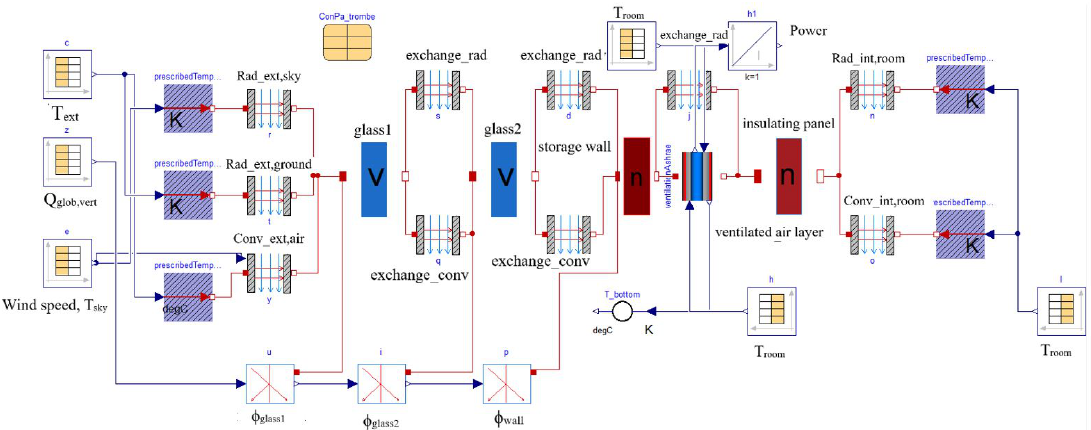
Figure 7. Diagram of a composite Trombe wall model using the Dymola/Modelica